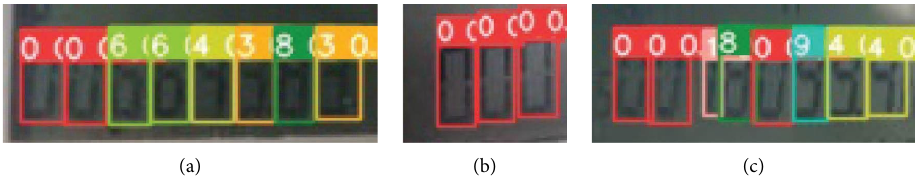
Figure 12: Developed OCR results. (a) Meter reading: 006643830. (b) Meter reading: 000. (c) Meter reading: